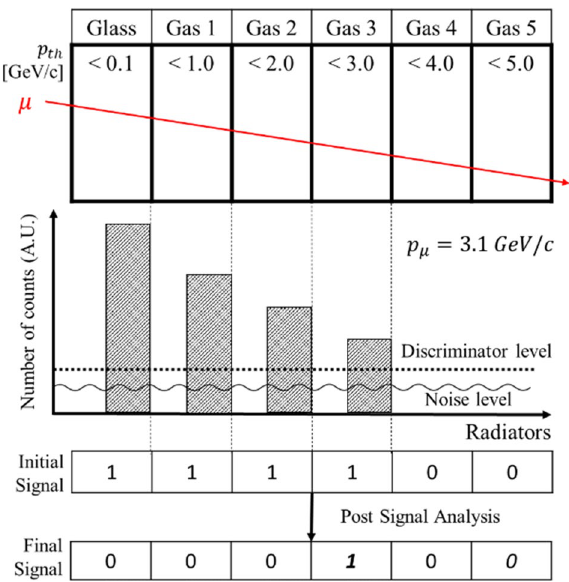
Figure 2. Signal flow diagram. The simplified schematic of signal flow to estimate muon momentum. In this example, only first four radiators emit Cherenkov radiation because the actual muon momentum is 3.1 GeV/c. Regardless of muon momentum, there always exists noise due to the scintillation, transition radiation, and electronic noise. Using a linear signal discriminator, the final signal correctly identifies the actual muon momentum with a resolution of ± 0.5 GeV/c 24